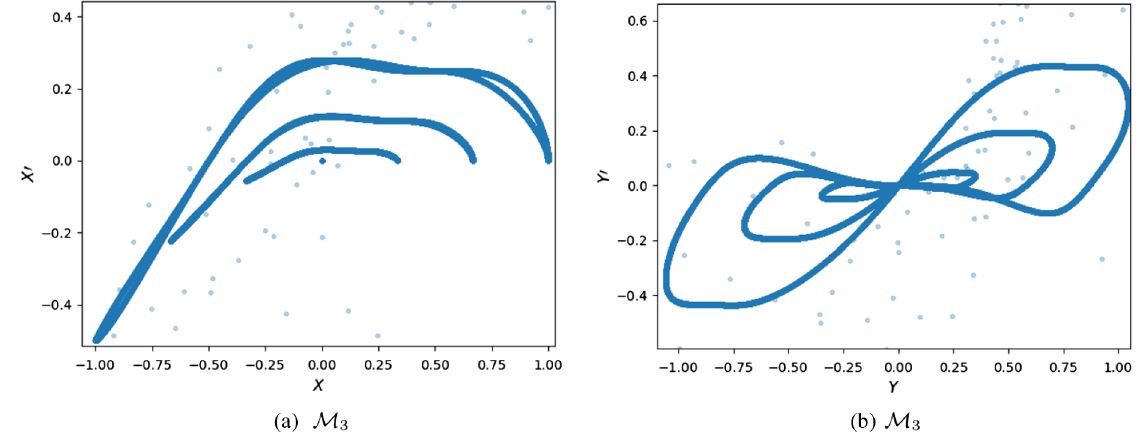
FIG. 10. Phase space portraits of M 3 (third-order coupled map), μ x ¼ μ y ¼ 1 = 4